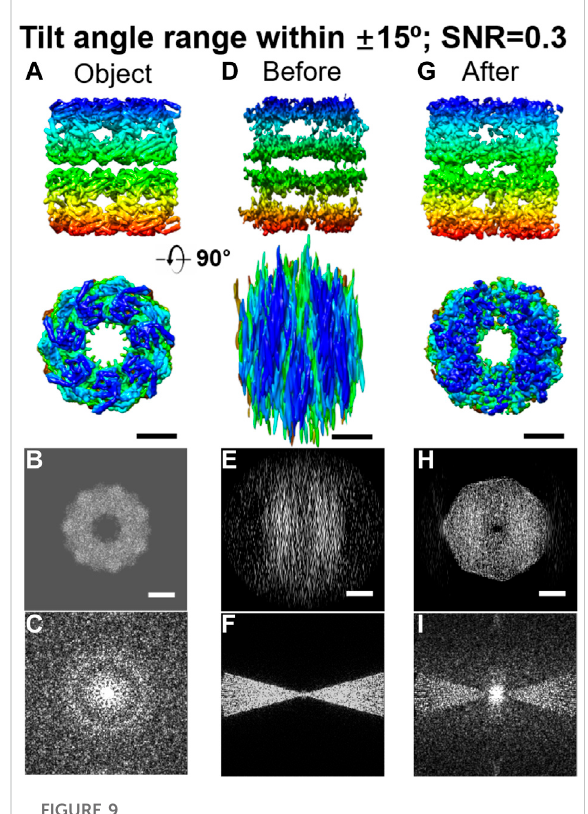
FIGURE 9 Missing-wedge correction on simulated 3D maps of reconstructed GroEL by LoTToR. (A) Two perpendicular views of the original object, a GroEL particle. (B and C) Projection and its Fourier transform of the 3D map along the X – Z plane. (D) Two perpendicular views of the initial 3D map, which was reconstructed from a noisy tilt series (SNR = 0.3) within a tilt angle rangeof±15 o instepsof1.5 o . (E and F) Itscorrespondingprojection andFouriertransformoftheinitial3DmapalongtheX – Zplane. (G) Final 3D map after missing-wedge correction (after 1,000 iterations), is shown from two perpendicular views. (H and I) Corresponding projection and Fourier transform of the fi nal 3D map along the X – Z plane. Scale bars: 50 nm. Reproduced with permission (Zhai et al.,